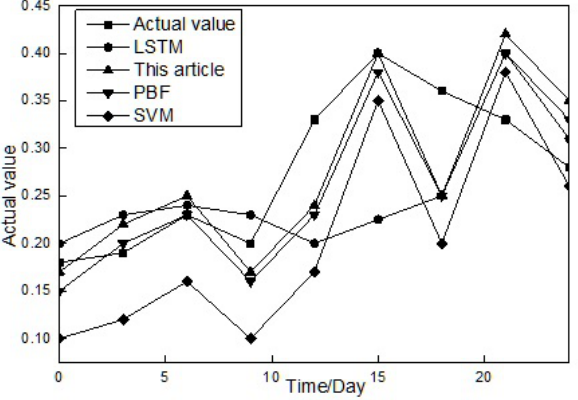
Fig. 8 Comparison of situation values predicted by different algorithms